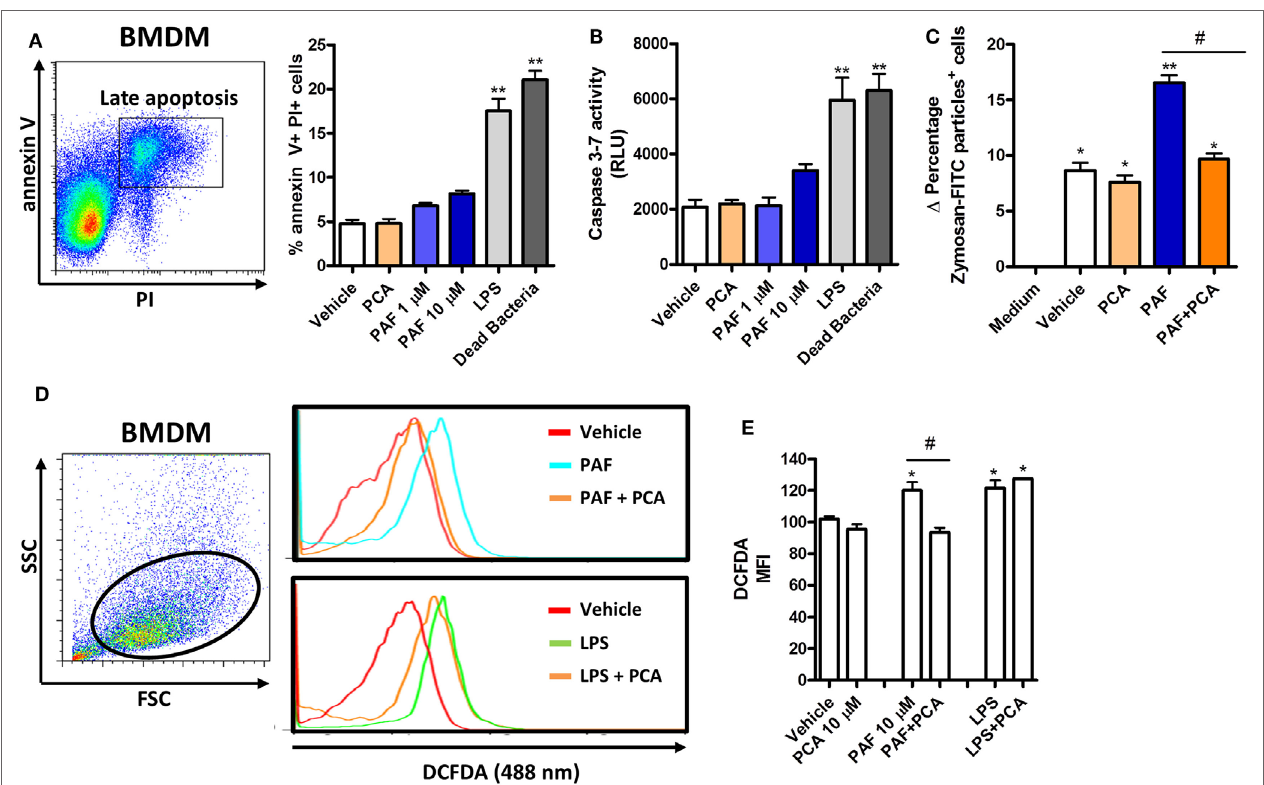
FigUre 3 | Exogenous platelet-activating factor (PAF) treatment does not impact cell viability and induces reactive oxygen species (ROS) release by chicken primary macrophages. (a) Representative flow cytometry dot plot and bar graph showing gating strategy for annexin V and propidium iodide (PI) expression analysis in bone marrow-derived macrophages (BMDM) from B13/B13 histocompatible chicken and percentage of double-positive stained cells, respectively, following treatment with PCA 4248 (10 µM), PAF (1 or 10 µM), Escherichia coli lipopolysaccharide (LPS) (10 ng/ml) or dead bacteria (10 multiplicity of infection) for 6 h. (b) Caspase 3–7 activity in BMDM following exposure to different stimuli for 6 h. RLU: relative luminescence units. (c) Delta percentage of BMDM containing zymosan-fluorescein isothiocyanate particles following different stimuli for 1 h as an index of phagocytosis (delta calculated after incubation at 4°C and 40°C). (D) Representative flow cytometry dot plot and histograms showing ROS release by BMDM, as determined by intracellular DCFDA fluorescence intensity, following different stimuli for 2 h. (e) Bar graph showing the mean fluorescence intensity (MFI) of DCFDA-positive BMDM following different stimuli for 2 h. Values are mean ± SEM. * P < 0.05, ** P < 0.01 when compared to negative (vehicle or medium) control groups. # P < 0.05 when compared to positive control